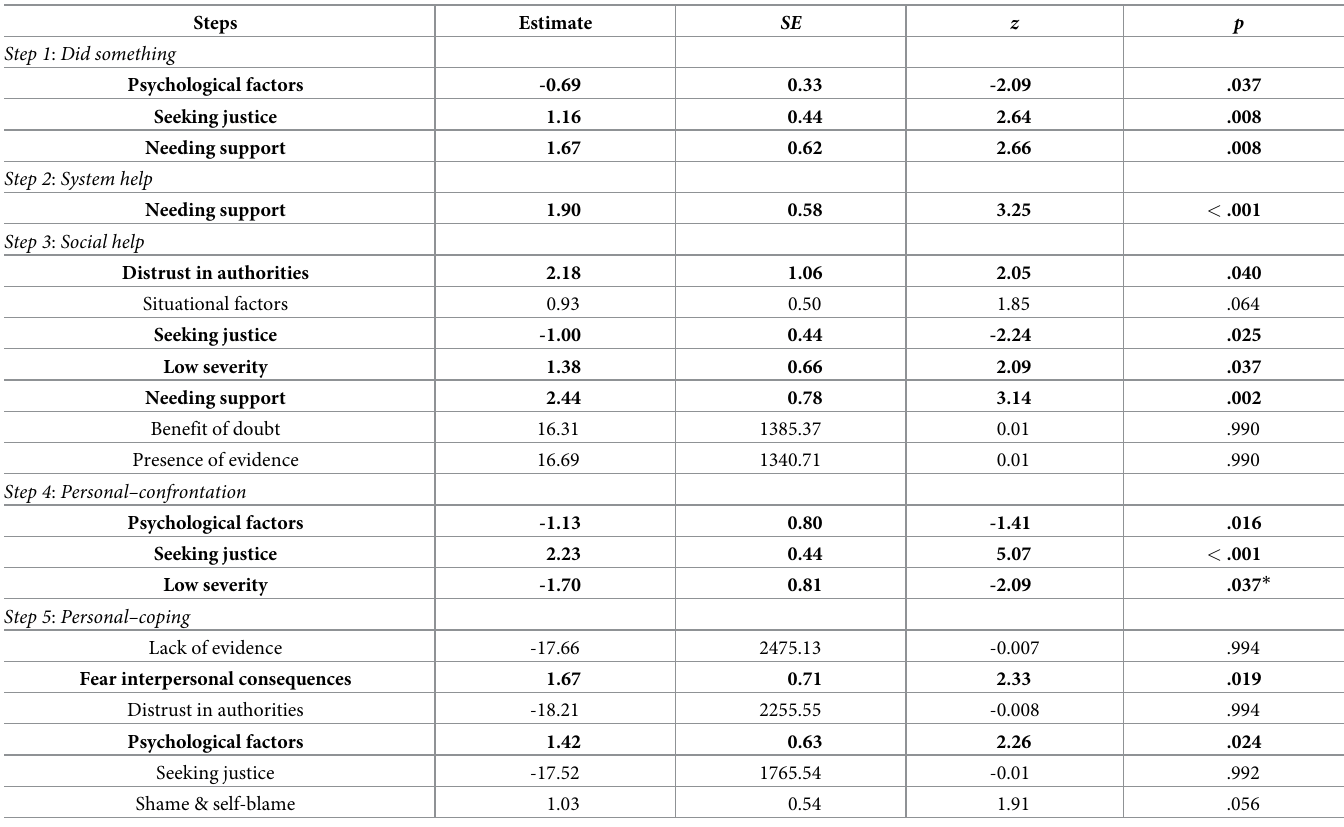
Table 5. Flowchart actions and reasons for self-reported victims of SA who reported being completely honest in their reports (Location 2 & Location 3; N =